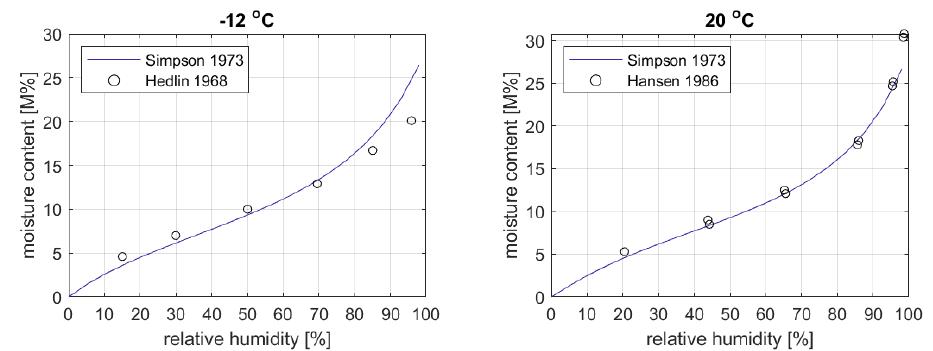
Figure 5. Comparison of the adsorption isotherms for − 12 °C and 20 °C [25] to experiments [29,41].